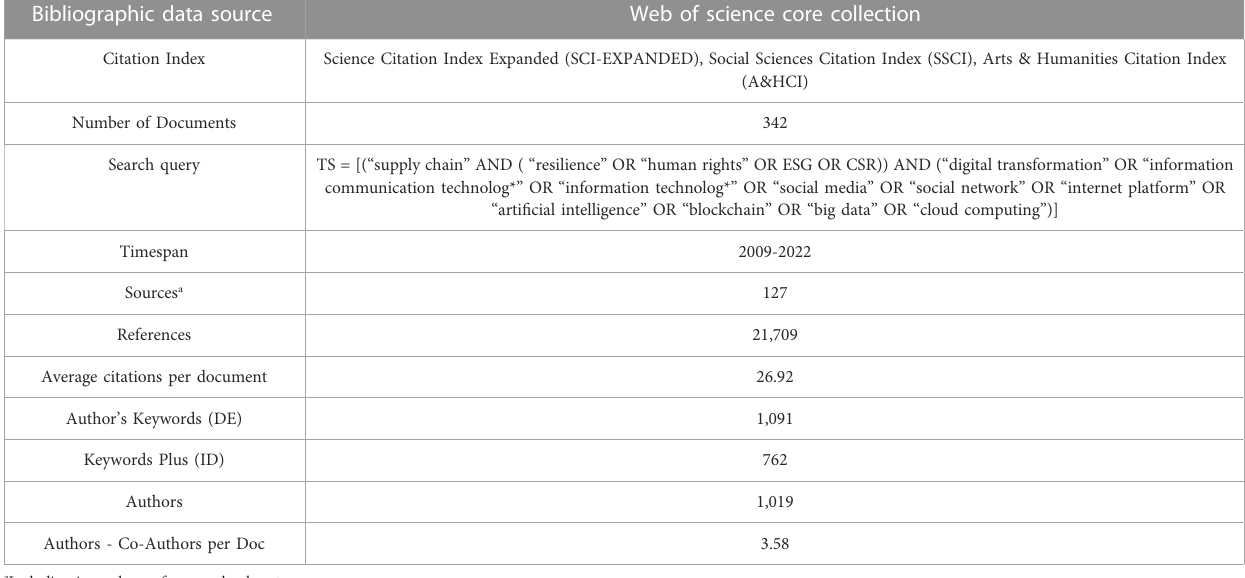
TABLE 1 Basic description of the data